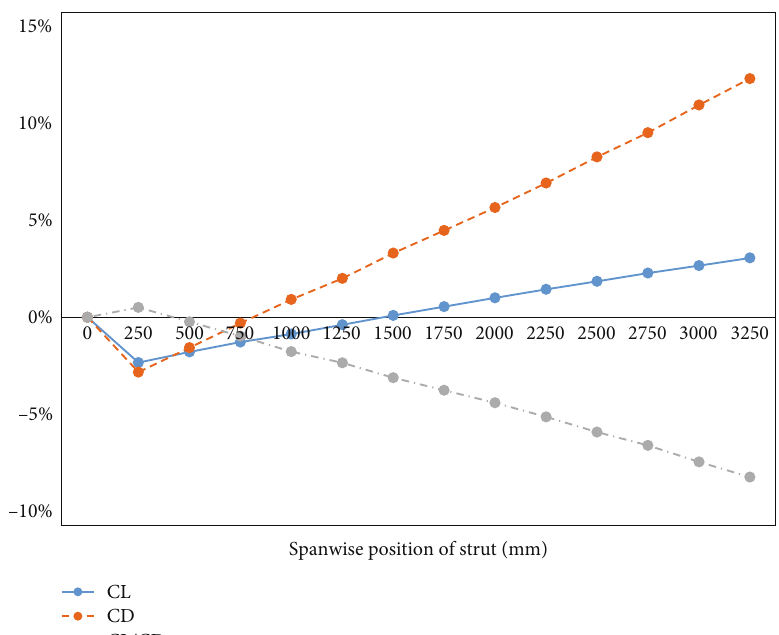
Figure 6: In fl uence of the spanwise position of the pylon on the lift-drag ratio.